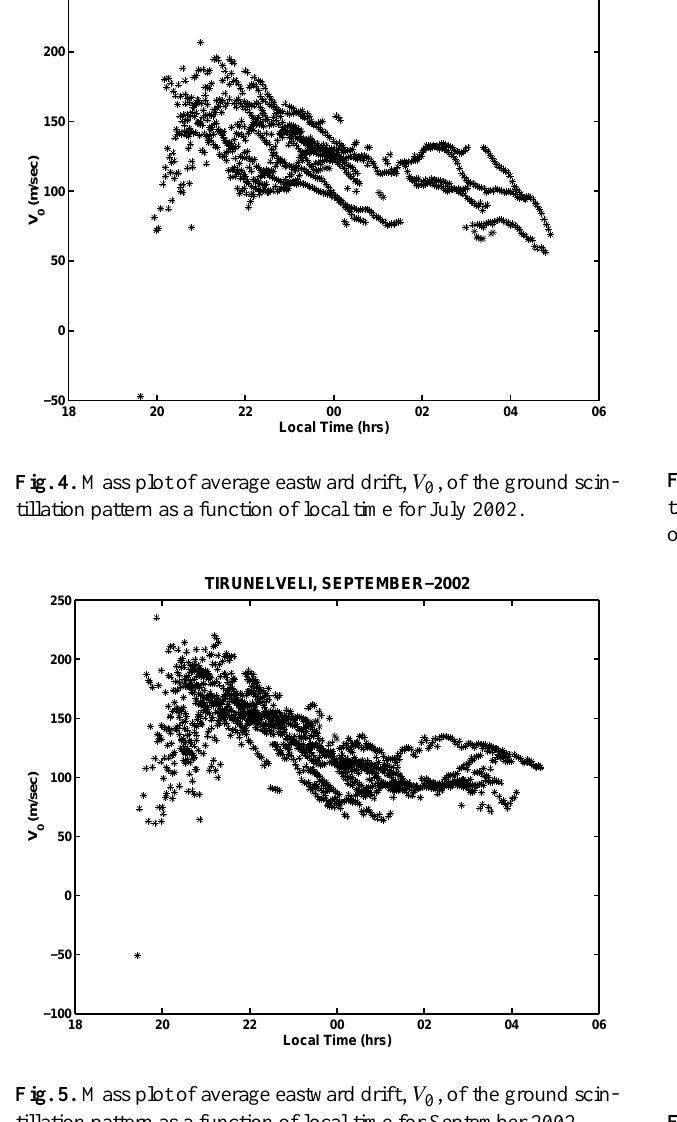
Fig. 7. Variation of coherence scale d I , for post-midnight weak scintillation patterns, with monthly average 10.7-cm solar flux (in units of 10 − 22 Wm − 2 Hz − 1